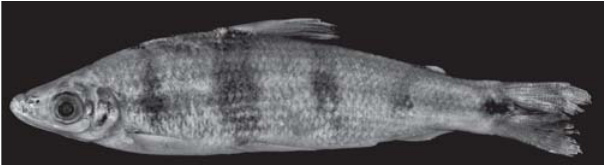
Fig. 9. Adult specimen of Laemolyta fernandezi, INPA 16177, 156.3 mm SL; Brazil, Pará, rio Tocantins, Lago Tauá below Tucuruí.